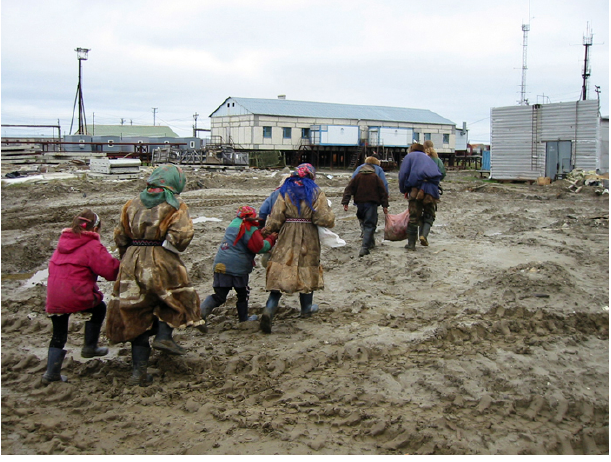
Fig. 9 . Nenets family bringing fresh reindeer meat to barter at BGF, July 2005. Photo by B.C.